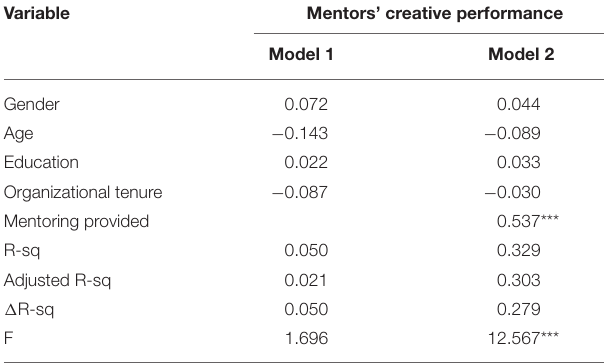
TABLE 2 | A summary of model fit indices. Model